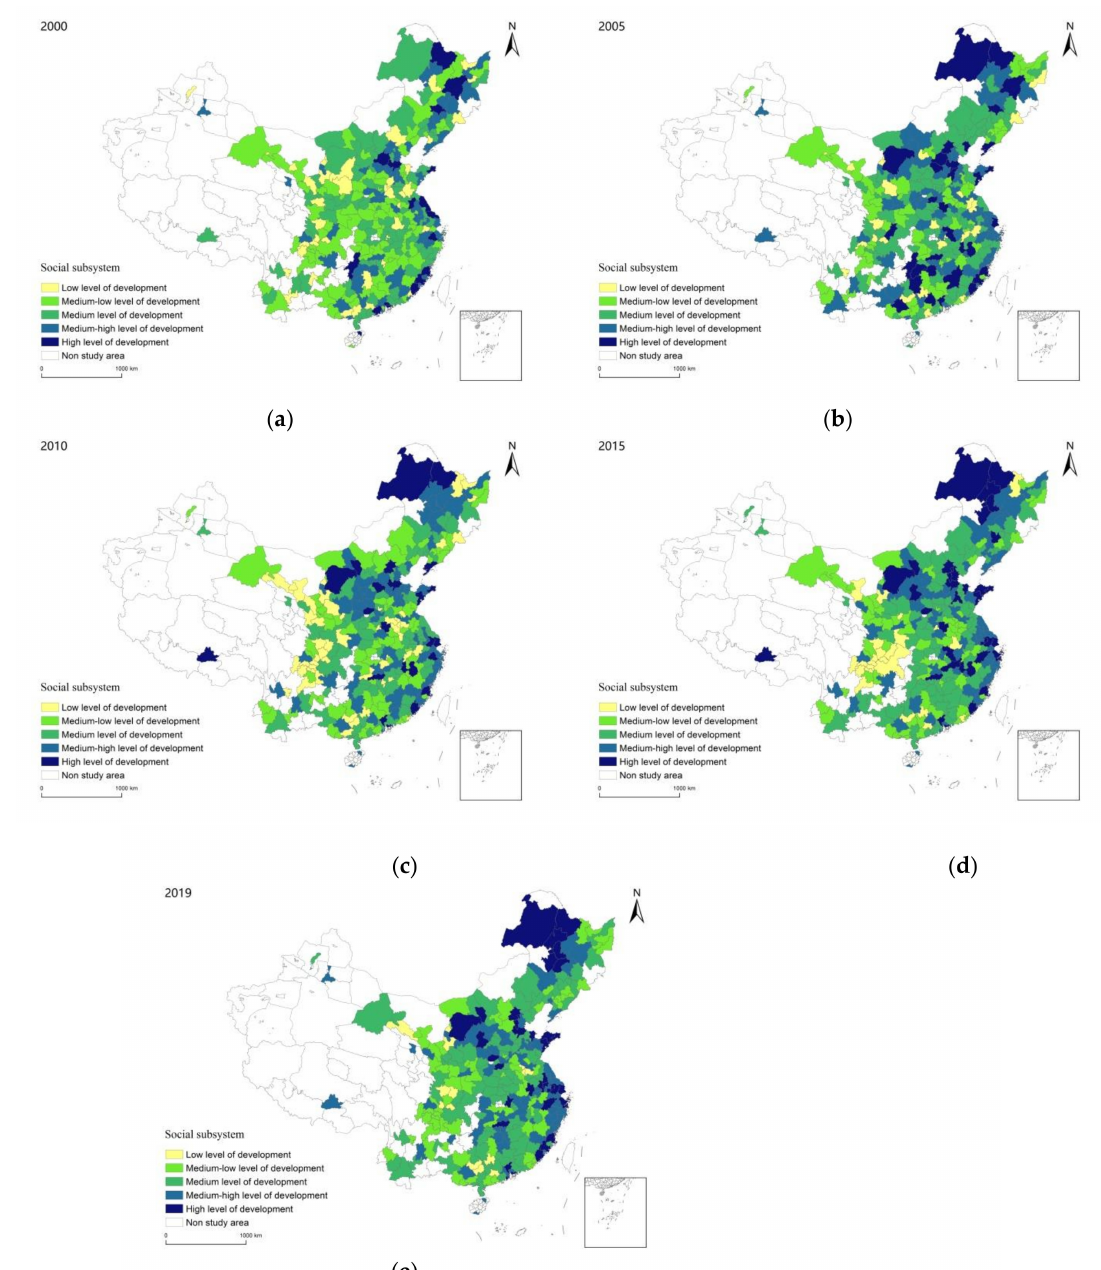
Figure 5. Spatial distribution map of the sustainable development level of the social system of urban human settlements in China. ( a ) 2000; ( b ) 2005; ( c ) 2010; ( d ) 2015; ( e )